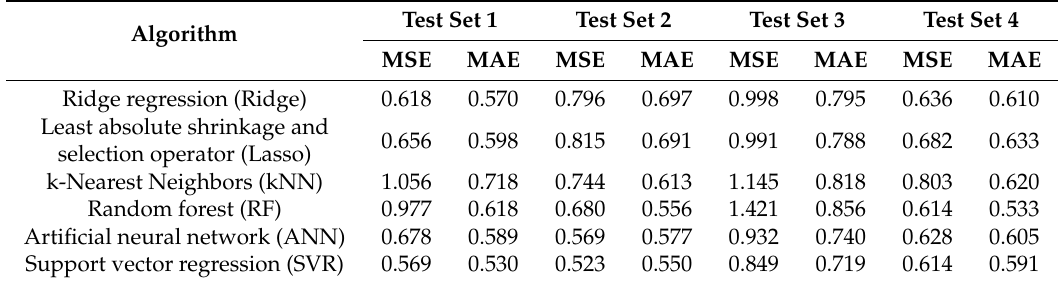
Table 5. MSE and mean absolute error (MAE) of different data-driven algorithms.